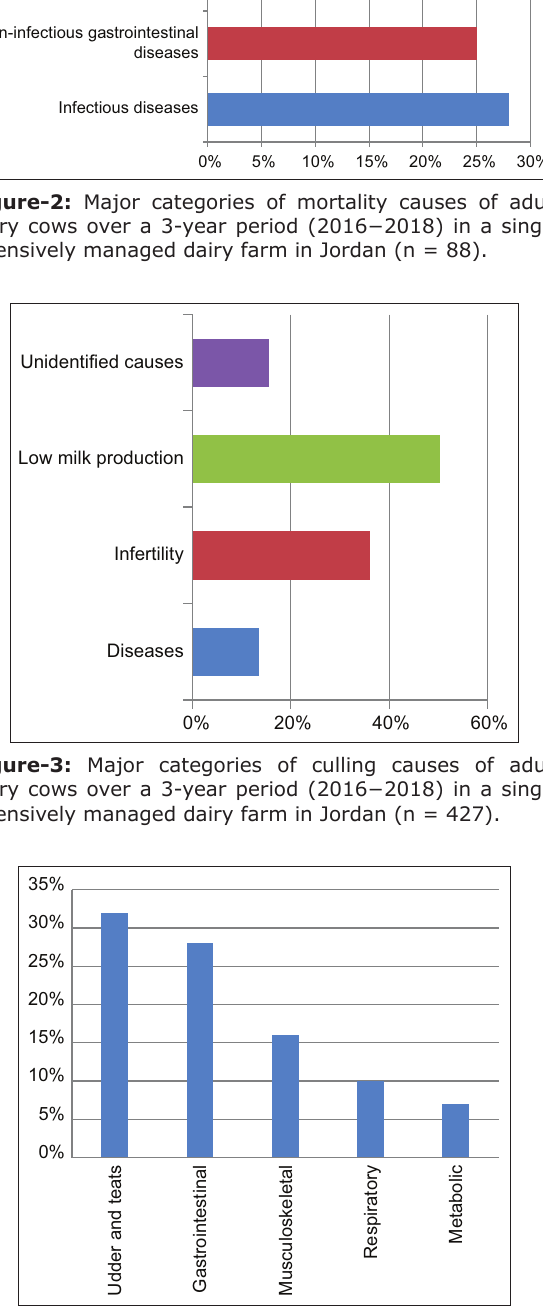
Figure-4: Body systems involved in diseases causing culling of adult dairy cows over a 3‑year period (2016−2018) in a single intensively managed dairy farm in Jordan (n =